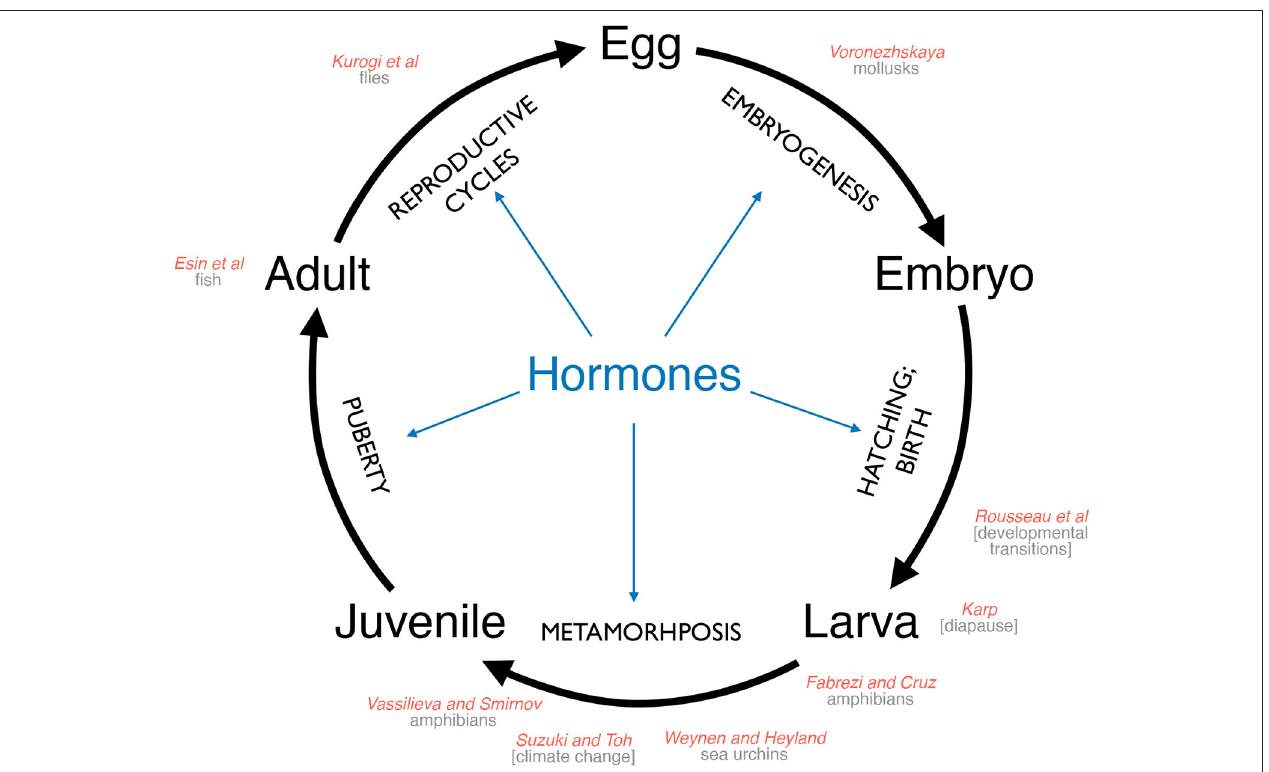
FIGURE 1 | A generalized metazoan life cycle. Transitions between each stage of life history require processes that involve hormones (shown in blue). The nine manuscripts in this special issue tackle different components of the metazoan life cycle in highly divergent organisms; each manuscript is cited (in red) near one of the life cycle stages or transitions on which the authors focus. The primary organism or broad subject of each manuscript is listed below in